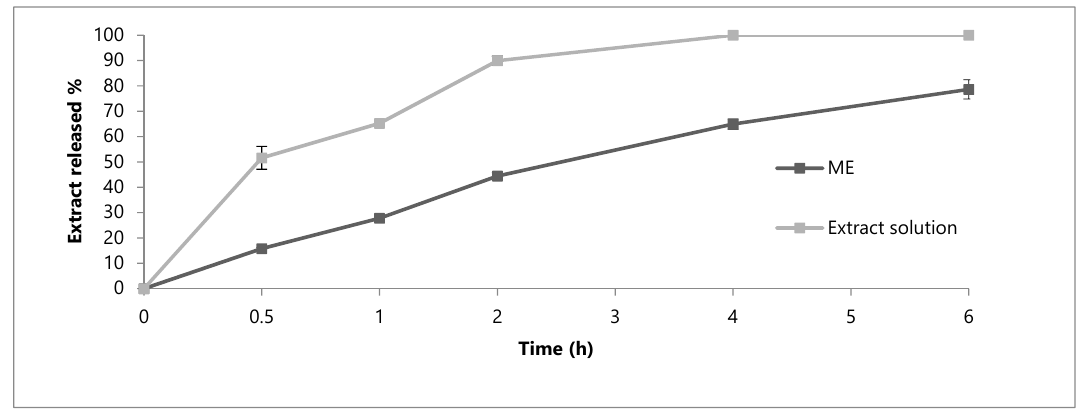
Figure 5. In vitro release profile of phenolic compounds from the OE-ME and OE ethanolic solution in Simulated Intestinal Fluid (SIF) medium at pH 6.8. Each value is the mean ± SD of three separate determinations.